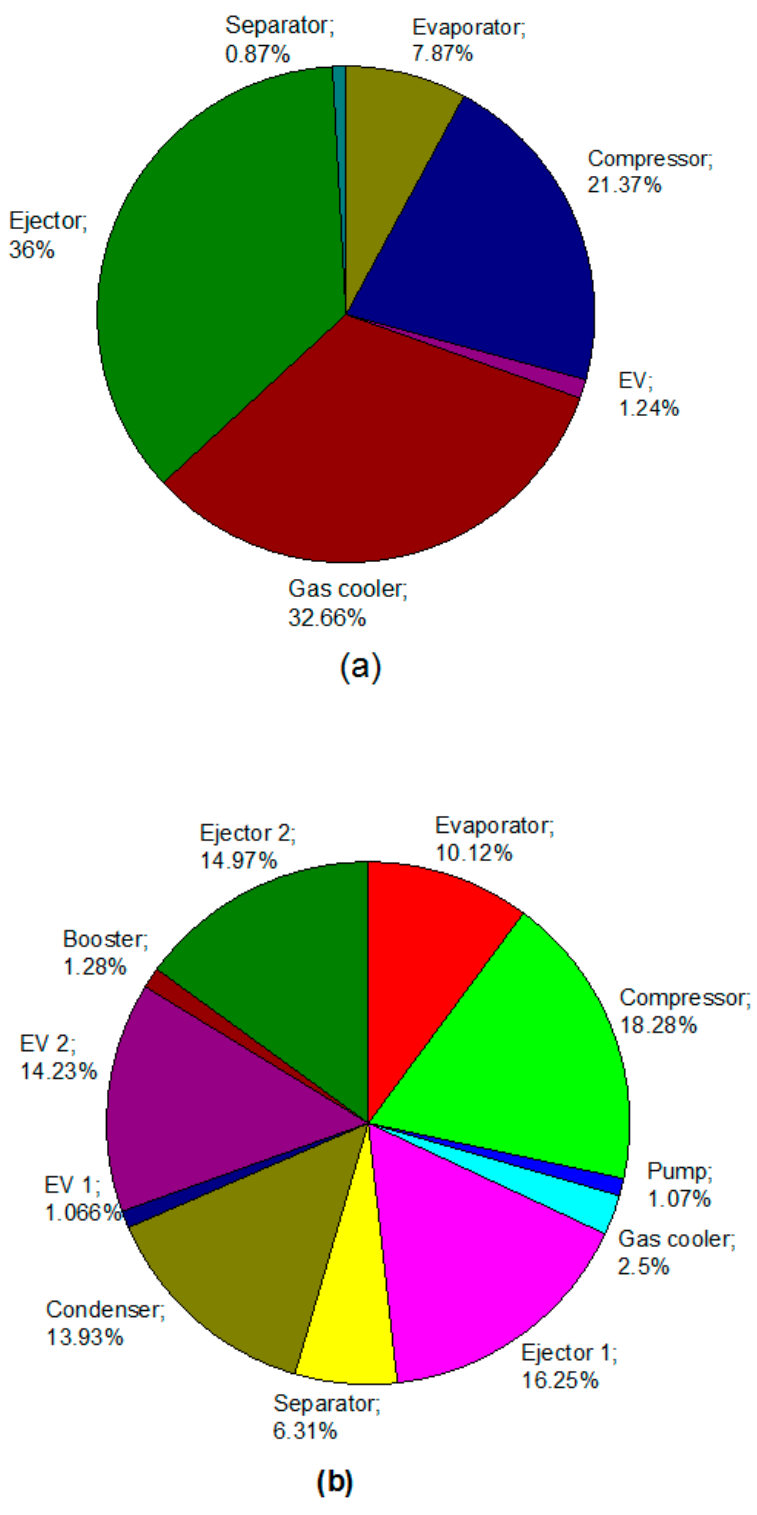
. E D , tot , ( a ) CERC, ( b )